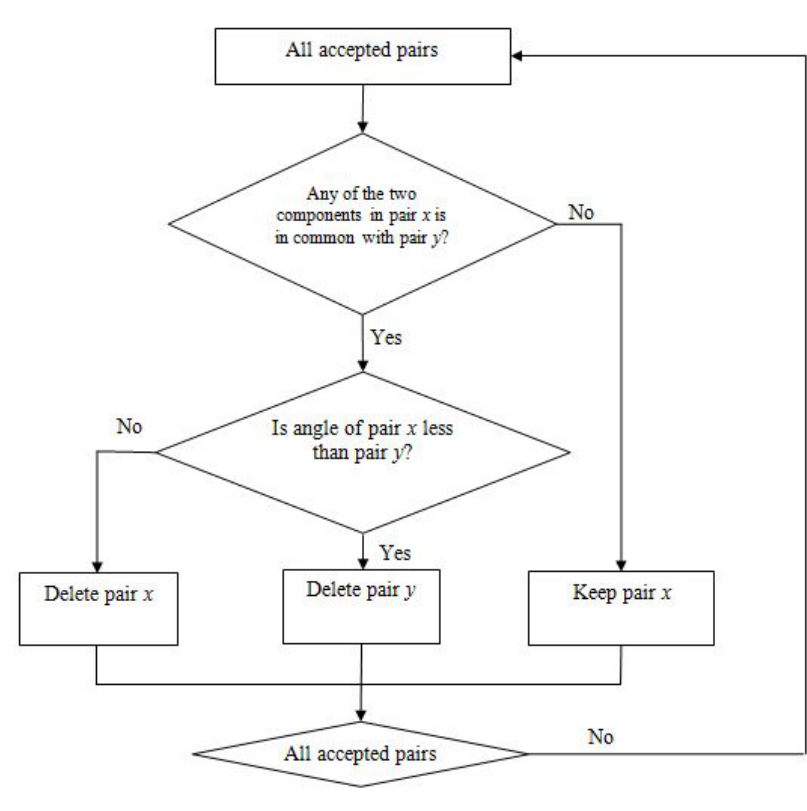
Figure 8. The pairing